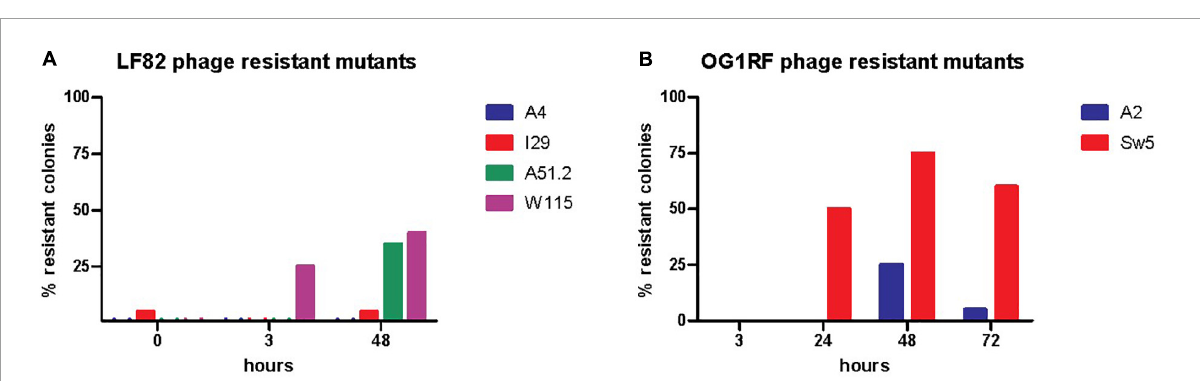
FIGURE6 Assessing the presence of phage resistant of (A) E. coli LF82 and (B) E. faecalis OG1RF as part of the SIHUMI-6 consortium when targeted by EE phage cocktail throughout a 72 h continuous